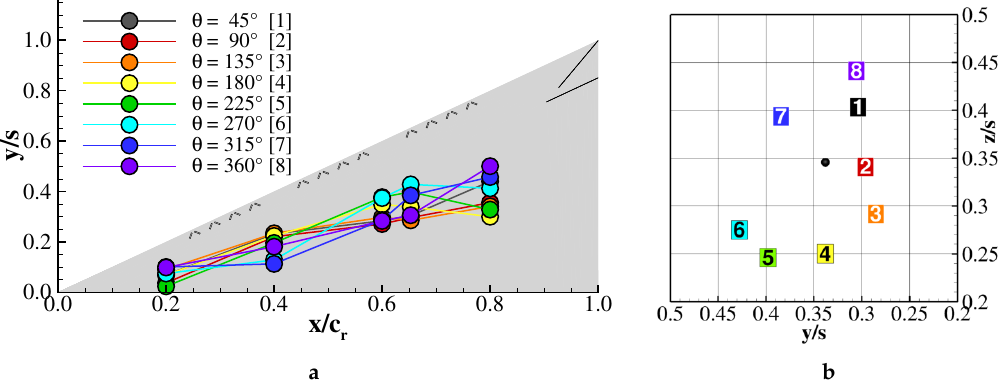
Figure 20. Phase averaged vortex axis location at α = 45 ◦ , F + = 1.0: ( a ) xy-plane and ( b ) x / c r =